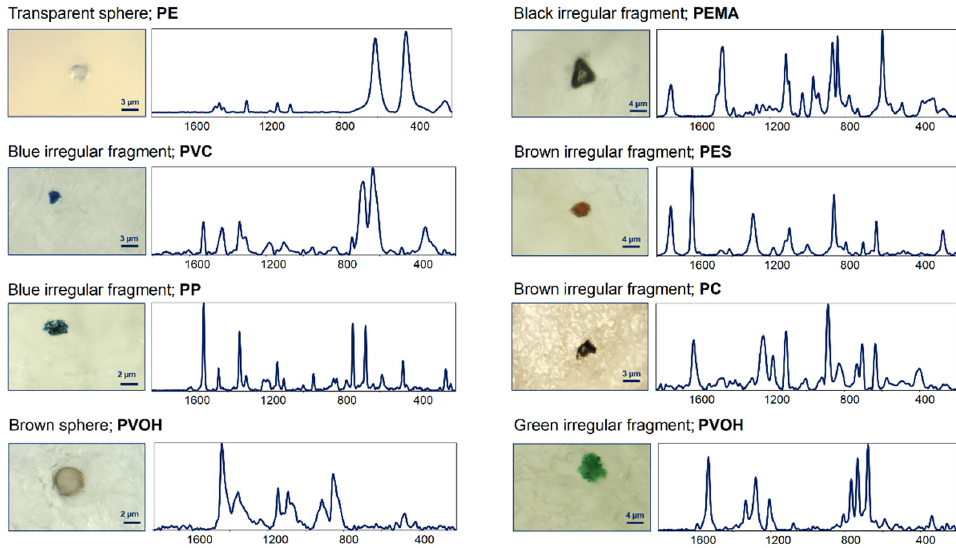
Figure 1. Microphotographs and Raman spectra (wavenumbers, cm − 1 ) of some selected MPs found in the analysed breastmilk samples. PE: polyethylene; PVC: polyvinyl chloride; PP: polypropylene; PVOH: polyvinyl alcohol; PEVA: poly(ethylene-co-vinyl acetate); PEMA: poly(ethyl methacrylate); PES: polyester, and PC: polycarbonate.